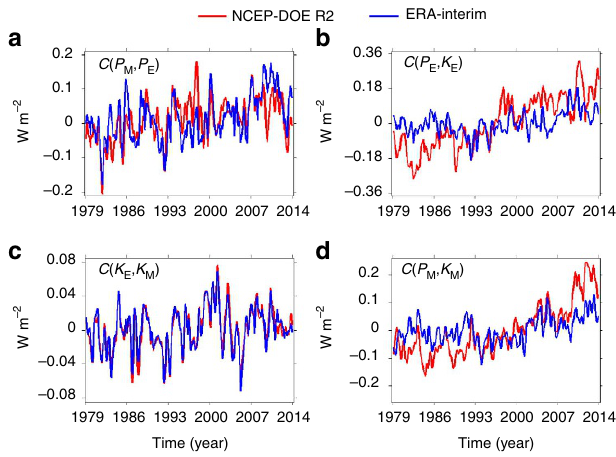
Figure 2 | Time series of the global-average conversion rates. ( a ) The conversion rate between the mean available potential energy and the eddy available potential energy C ( P M , P E ). ( b ) The conversion rate between the eddy available potential energy and the eddy kinetic energy C ( P E , K E ). ( c ) The conversion rate between the eddy kinetic energy and the mean kinetic energy C ( K E , K M ). ( d ) The conversion rate between the mean available potential energy and mean kinetic energy C ( P M , K M